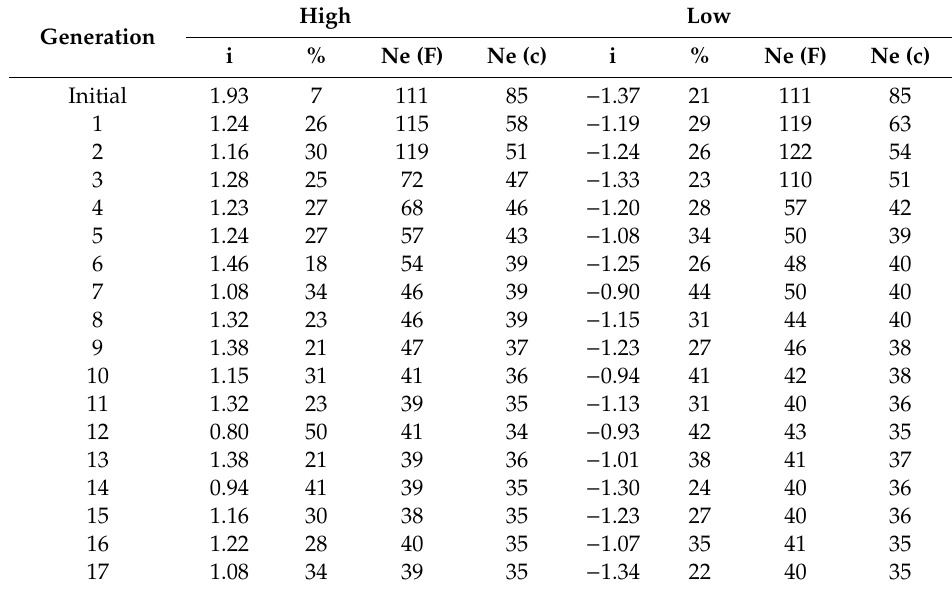
Table 2. Selection intensity (i), equivalent proportion selected (%), and e ff ective population size in both high and low variability lines in all generations selected for birth weight environmental variability. High Low Generation